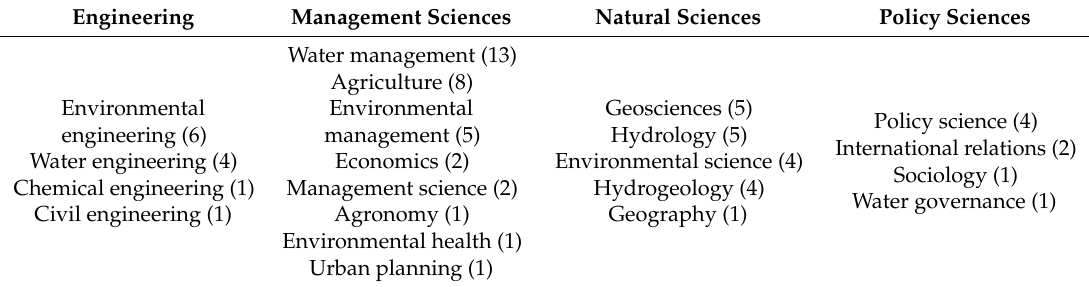
Table 8. Disciplines per category as mentioned by the respondents (Number of mentions are shown in brackets).